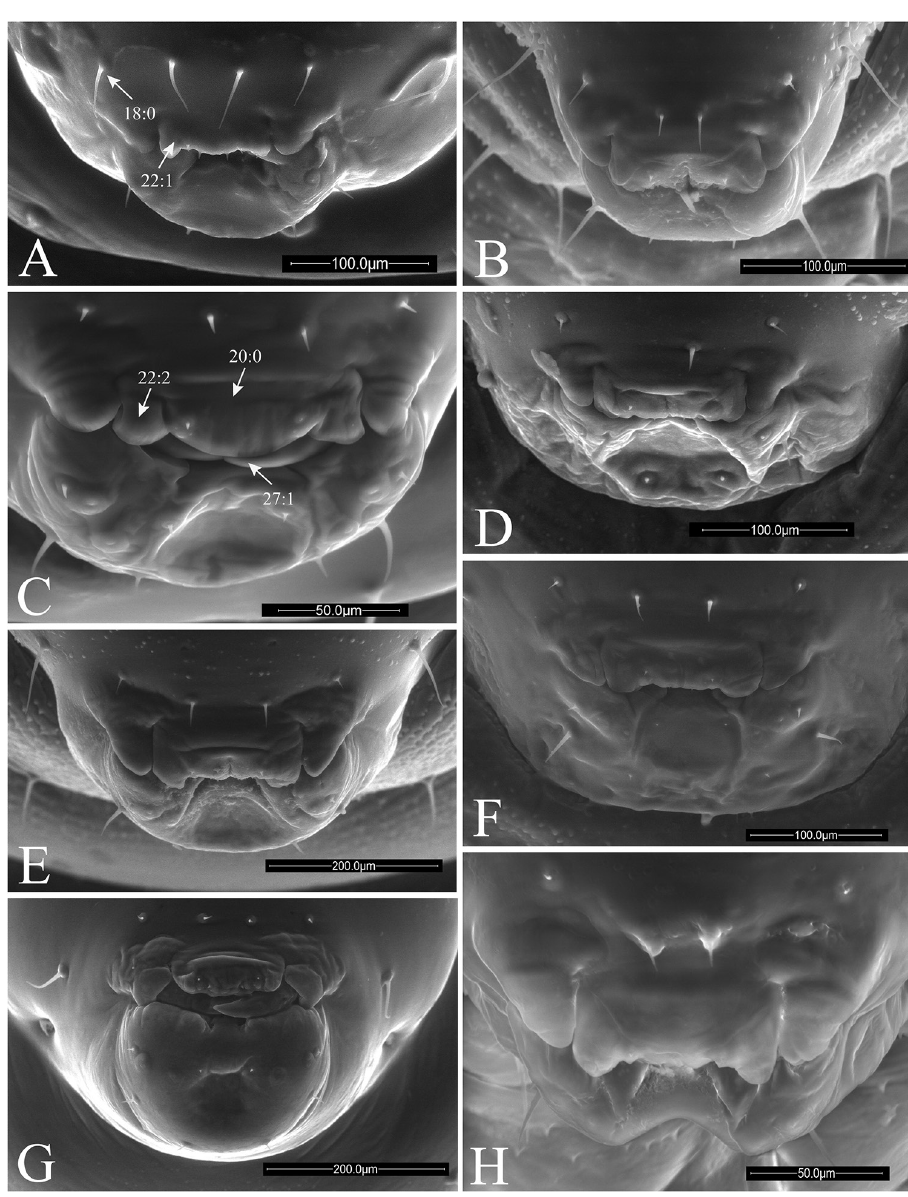
Figure 9. Anterior views of mouthparts of Ormyrus terminal-instar larvae. A Ormyrus capsalis B O. cupreus C O. diffinis D O. gratiosus E O. nitidulus F O. orientalis G Ormyrus papaveris H O. pomaceus ex Trigonaspis mendesi (Cynipidae). Character states for outstanding features are arrowed. ilex, n = 11; Body length: 2.21 ± 0.46 mm (min-max: 1.80–3.40 mm), width: 1.10 ± 0.10 mm (min-max: 0.93–1.27 mm); ex gall Trigonaspis mendesi on Quercus faginea , n = 1; Body length: 1.55 mm, width: 0.80